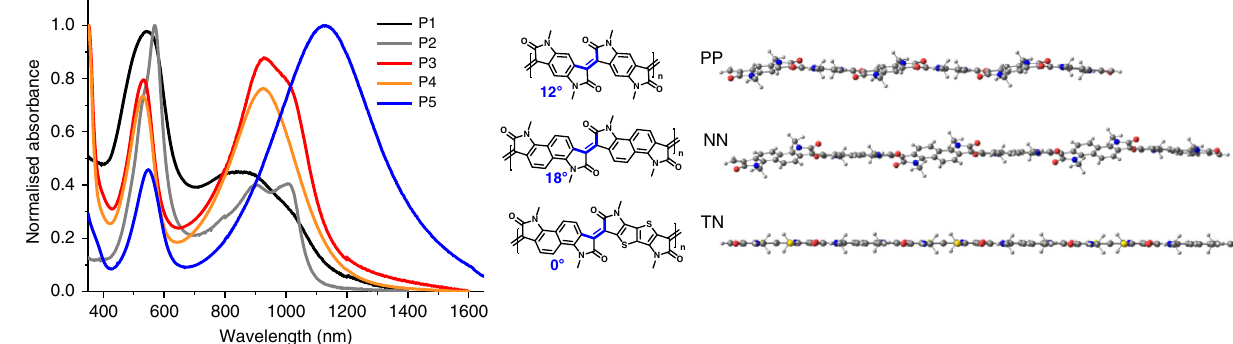
Fig. 4 Thin fi lm UV-Vis-NIR absorption spectra and DFT conformational analysis of the polymers. The fi lms were spun from chlorobenzene solutions. P1 and P2 have an all-phenyl core structure (PP), P3 and P4 have an all-naphthalene core and P5 has a thieno[3,2-b]thiophene − naphthalene structure (TN). The molecular geometries were optimised at the ω B97XD/6-31g(d,p) level of theory. The optimal dihedral angles (in degrees) between adjacent aromatic units are shown in blue; the inter-unit double bonds (also highlighted in blue) are 1.37 Å